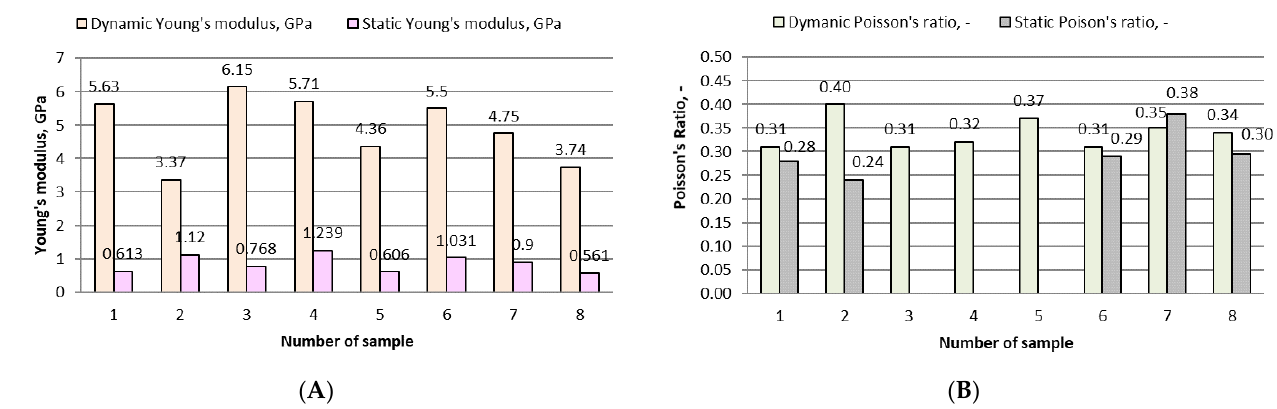
Figure 11. Static and dynamic values of Young’s modulus ( A ) and Poisson’s ratio ( B ) for coals sampled from the same locations in mine workings.